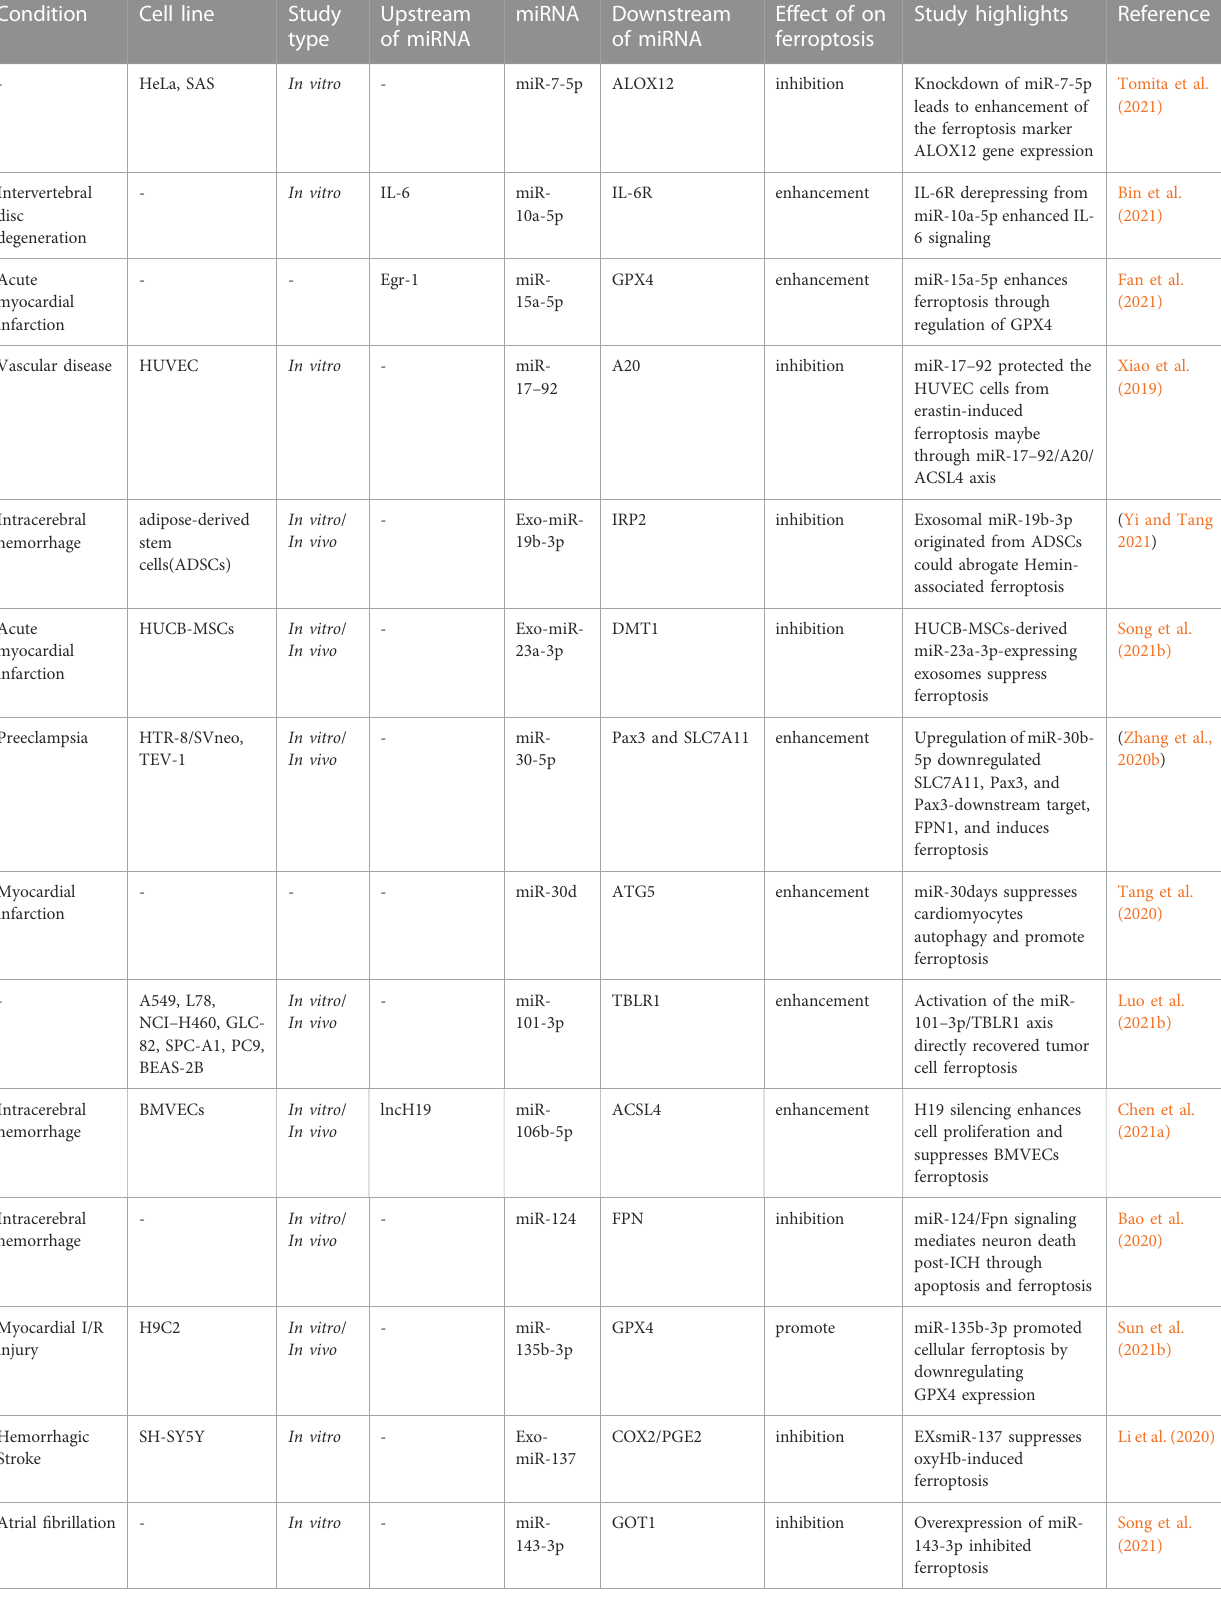
TABLE 2 miRNAs effect on ferroptosis in non-malignant conditions.